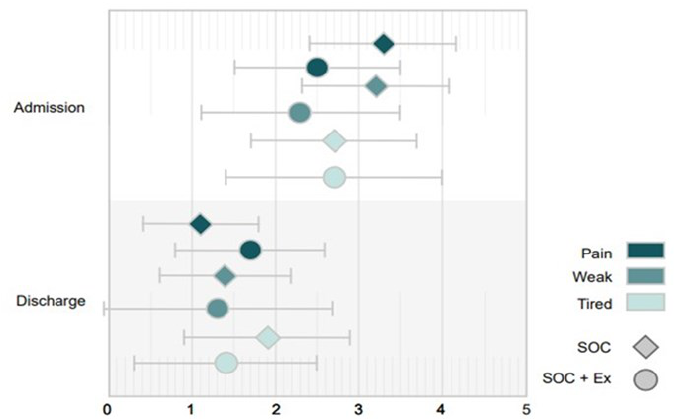
Figure 2. Patient-reported physical item scores at admission and discharge. Different coloring indicates physical score items: pain, weak, tired. All scores were lower at discharge than at admission, indicating improvement ( p < 0.05). Adding exercise had no additional benefits. SOC, standard of care; SOC+Ex, standard of care plus exercise.